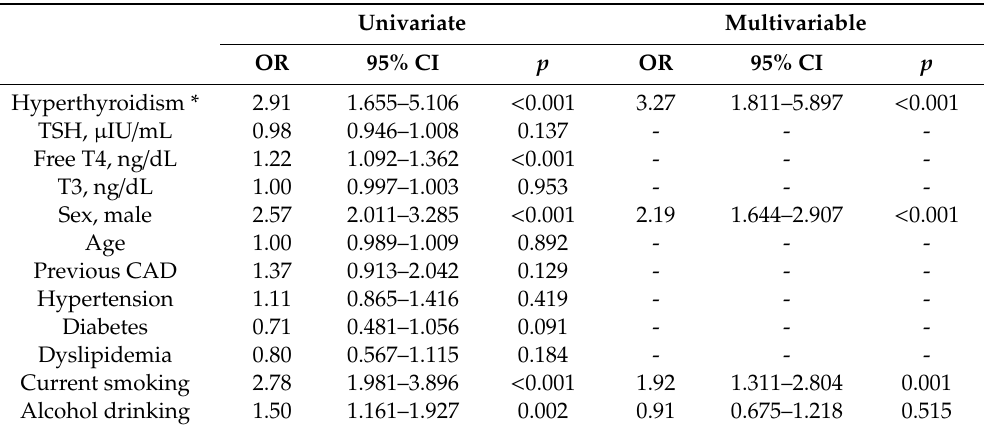
Table 2. Predictors of Vasospastic Angina.